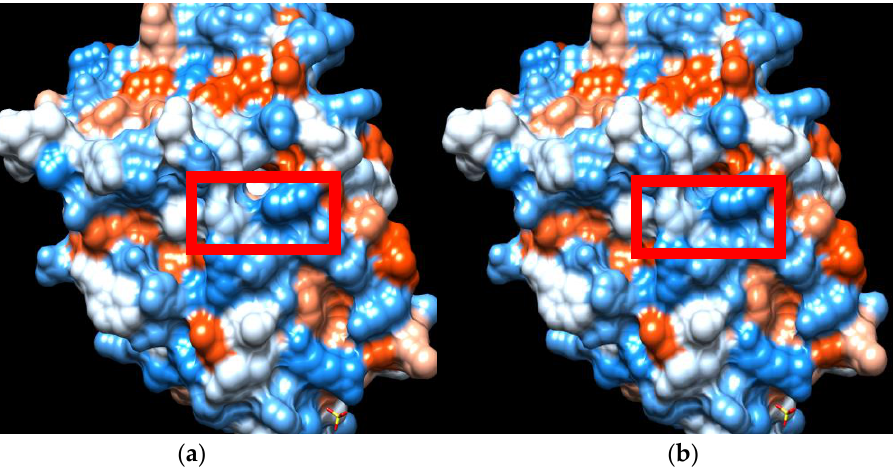
Figure 2. Modification of hydrophobicity between wild type AR ( a ) and Ala871Glu mutant AR ( b ). (Red-hydrophobic region, blue-hydrophilic).